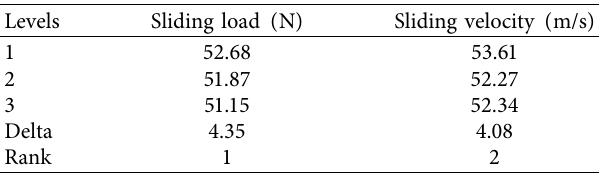
2 -9% composites). Table 6: Wear rate AAZrB 2 -9% hybridized composites optimum response table: smaller is better.